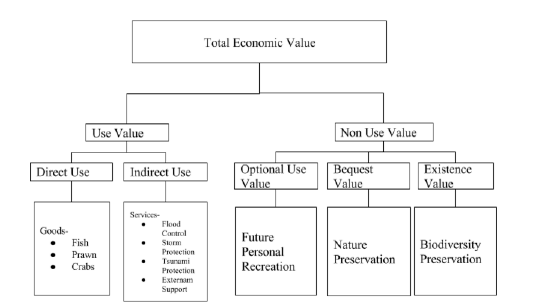
Figure 1: Figure describes different economic uses of the Man-